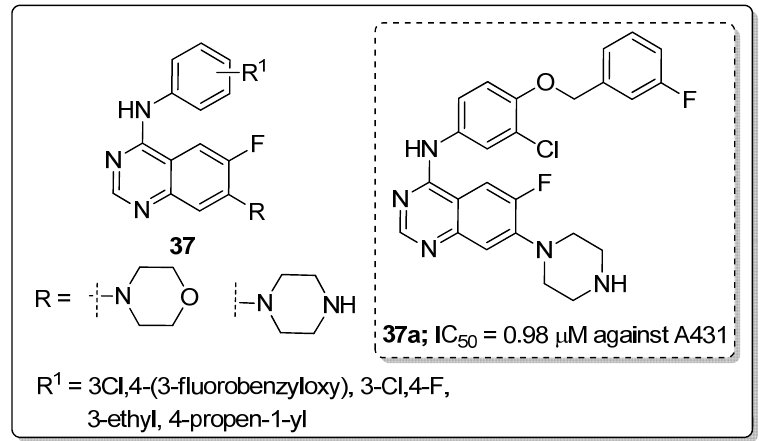
Figure 43. Antitumor activity of the most active quinazoline conjugate 37a .